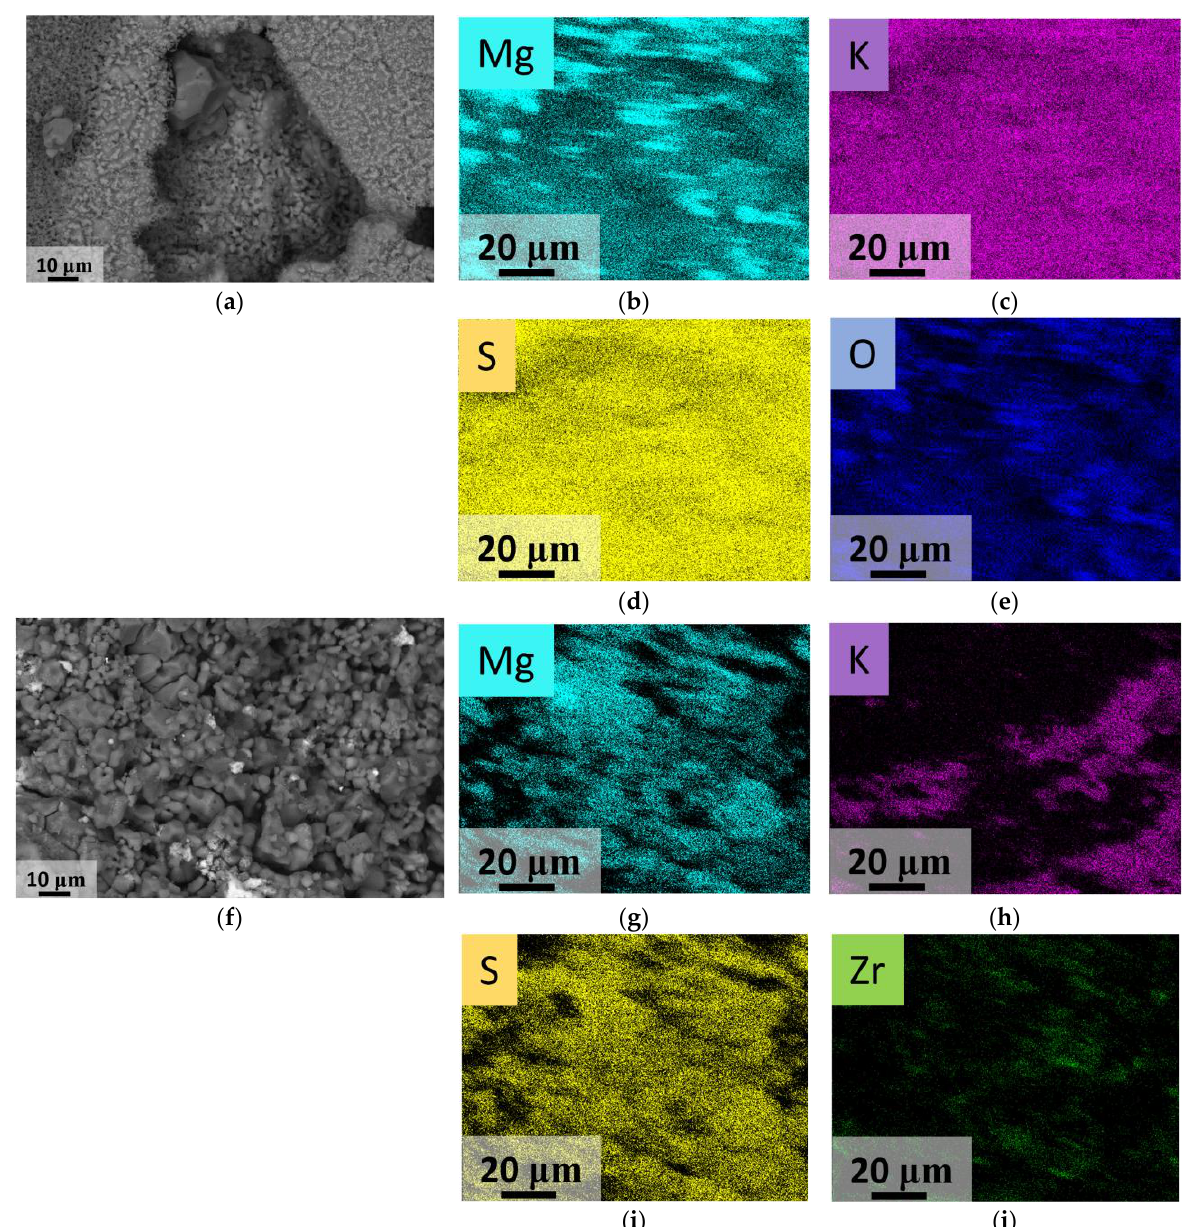
Figure 11. ( a , f ) SEM images (SE2) of the fractured Mg10K and Mg10KY-TZP samples; ( b – e , g – j ) corresponding elemental maps.